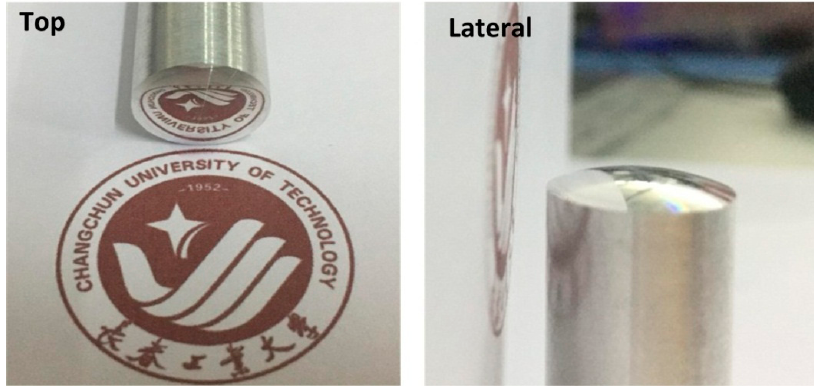
Figure 11. Convex spherical surface topography of titanium alloy machined by a non-resonant three-dimensional elliptical vibration cutting (3D-EVC) apparatus ( f 3D = 50 mm/min, S = 50 mm/min, A = 7 μ m, D = 1 μ m and F = 0.2 mm·min − 1 ). ( left ) Top view; ( right ) Lateral view.